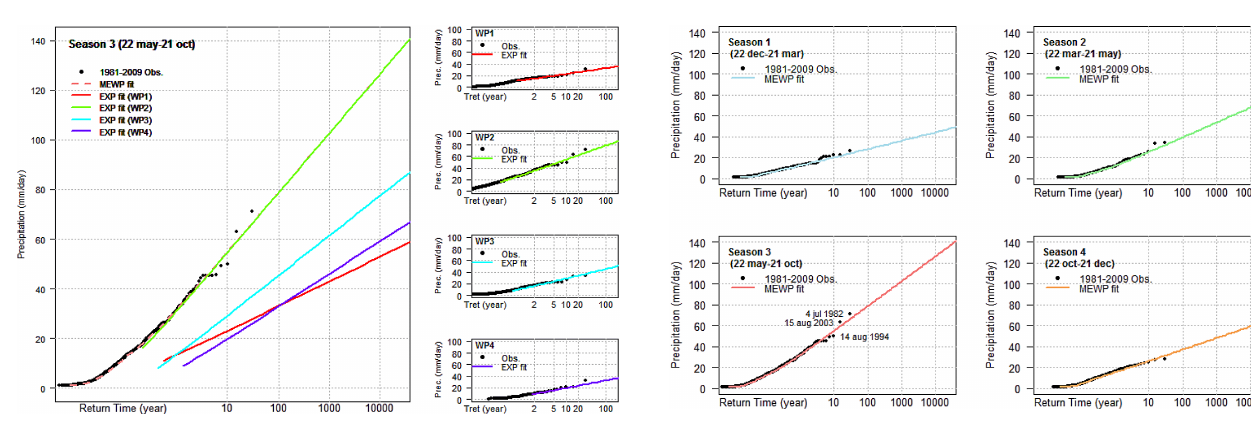
Figure 6. Example of WP-based fits for the June–October season at Atnasjø (right) with the resulting seasonal MEWP distribution (left).